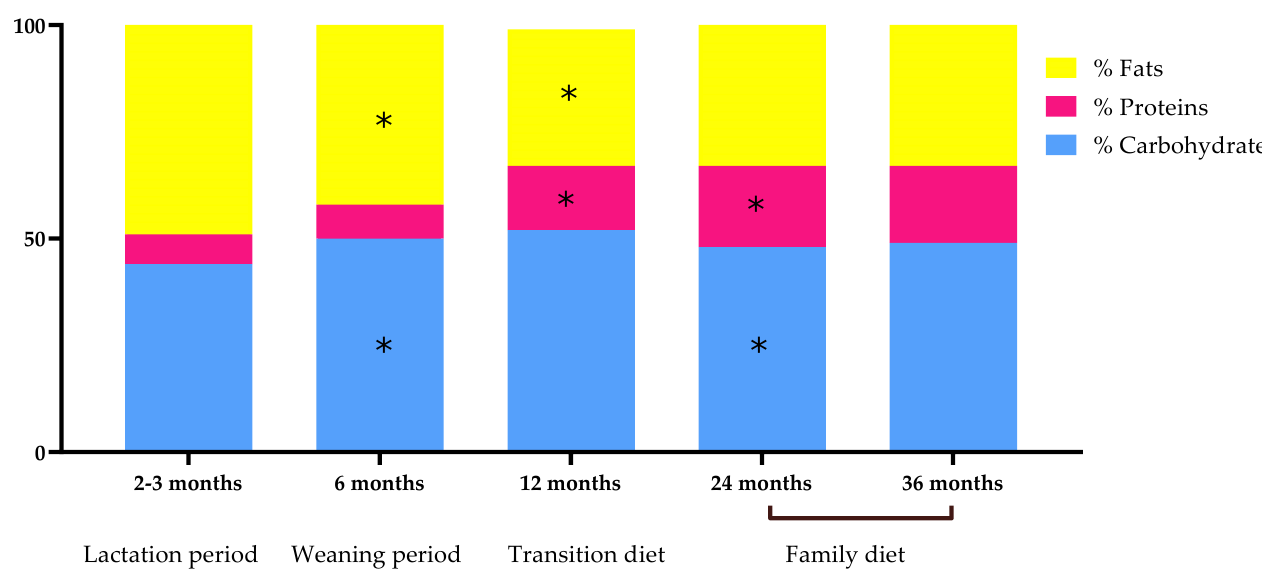
Figure 3. Percentage of the total energy intake provided by each macronutrient across the follow up. Mean daily energy intake: lactation period 538.64 kcal; weaning period 726.74 kcal; transition diet 1046.94 kcal and family diet at 24 months 1147.50 kcal and 36 months 1282.36 kcal. * p -Value < 0.05 from Kruskal – Wallis test compared to the previous category.